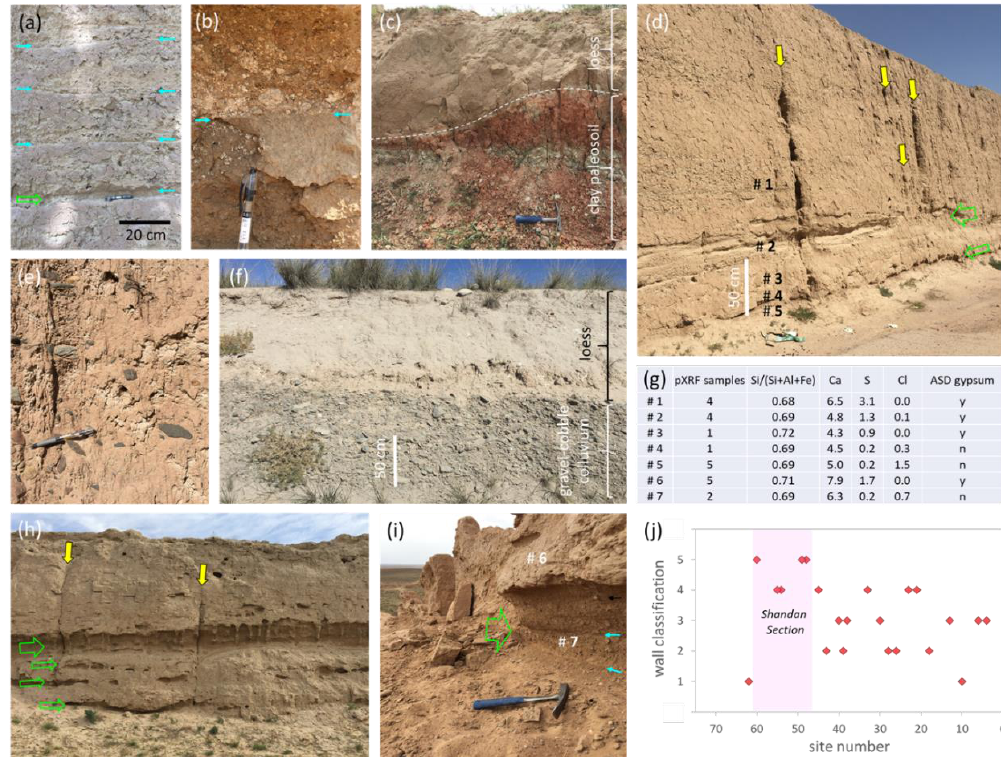
Figure 2. Field site photos and data. ( a ) Twenty-centimeter-wide layering of the Ming earthen wall (cyan arrows) at Site 48 (38 ◦ 19.33 (cid:48) N; 101 ◦ 58.25 (cid:48) E. ( b ) Abundant white clay-carbonate fragments within “hangtu” construction layers at Site 28 (37 ◦ 56.29 (cid:48) N; 107 ◦ 13.49 (cid:48) E). ( c ) A recently exposed cutting < 1 km from Site 28 exposing a ~1 m thick surface layer of loess developed over an eroded red and white horizontal layered clay-rich paleosol with white clay-carbonate fragments. ( d ) South-side view of the well-preserved earthen wall at Site 48 (38 ◦ 19.33 (cid:48) N; 101 ◦ 58.25 (cid:48) E). Preferentially eroding “hangtu” layers are shown by green arrows while sub-vertical rills are shown by yellow arrows. Field sampling points for pXRF and ASD measurements are numbered (#). ( e ) Close-up view at Site 48 showing isolated, sub-rounded grey siltstone pebbles and cobbles in a beige colored loess matrix. ( f ) A road cutting along the Shandan section (38 ◦ 27.40 (cid:48) N; 101 ◦ 27.53 (cid:48) E) showing a ~1 m thick surface layer of loess developed over grey, sub-rounded, siltstone pebbles, and cobbles similar to those evident in ( e ). ( g ) A table of field pXRF chemistry and ASD gypsum information of selected sample points (#) in ( d , i ). ( h ) Preferential erosion along multiple “hangtu” layers at Site 33 (38 ◦ 16.34 (cid:48) N; 106 ◦ 32.18 (cid:48) E). ( i ) Recent collapse of the earthen wall at Site 38 (37 ◦ 57.34 (cid:48) N; 105 ◦ 47.78 (cid:48) E) related to undercutting along a ~50 cm wide erosional zone (#7) rich in halite. ( j ) Visual classification of the earthen wall’s erosional status where: 1 = little remaining of the original wall above the exposed land surface; and 5 = well-preserved wall, including the remnants of battlements. The magenta box highlights the well-preserved Shandan